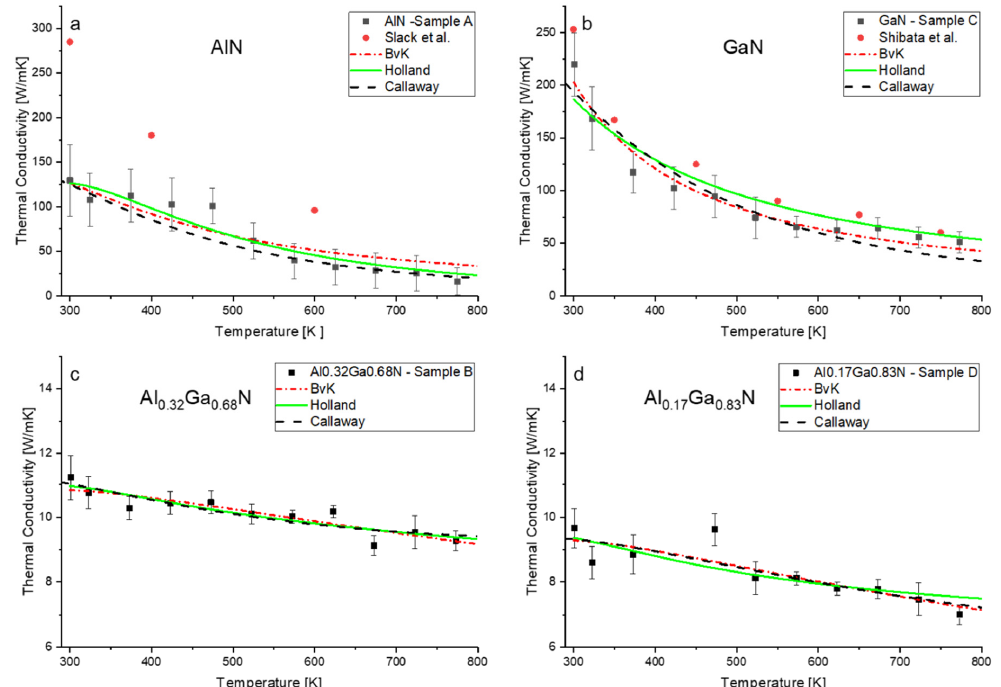
Figure 2. Measured and calculated thermal conductivities as a function of temperature. Measured κ of ( a ) AlN, ( b ) GaN, ( c ) Al 0.32 Ga 0.68 N, and ( d ) Al 0.17 Ga 0.83 N are marked as black squares, while thermal conductivities from literature are shown as red circles. Solid lines depict the models for lattice thermal conductivities, describing the scattering processes in the materials (dotted-dashed red: Born-von Karman, solid green: Holland and dashed black: Callaway model).